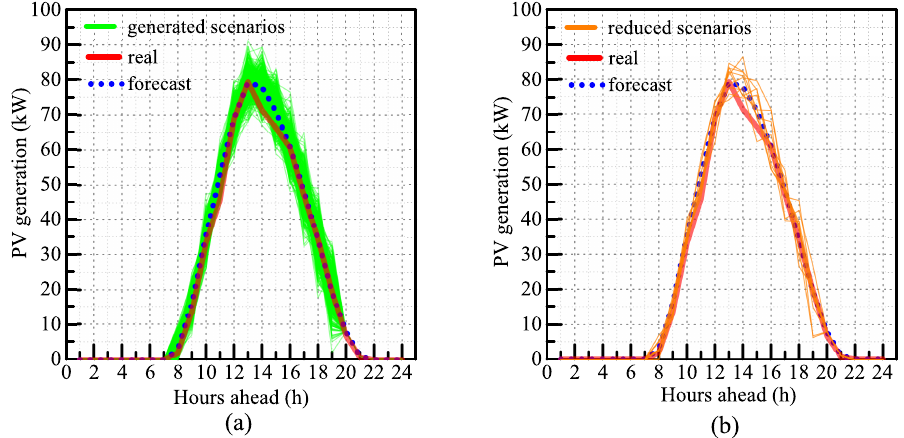
Figure 6. Scenario generation and reduction of aggregated photovoltaic (PV) power production ( a ) generated 500 PV scenarios for 24 h ahead with increasing standard deviation; ( b ) reduced set of 10 final scenarios by applying the BRA algorithm to the original 500 scenarios.